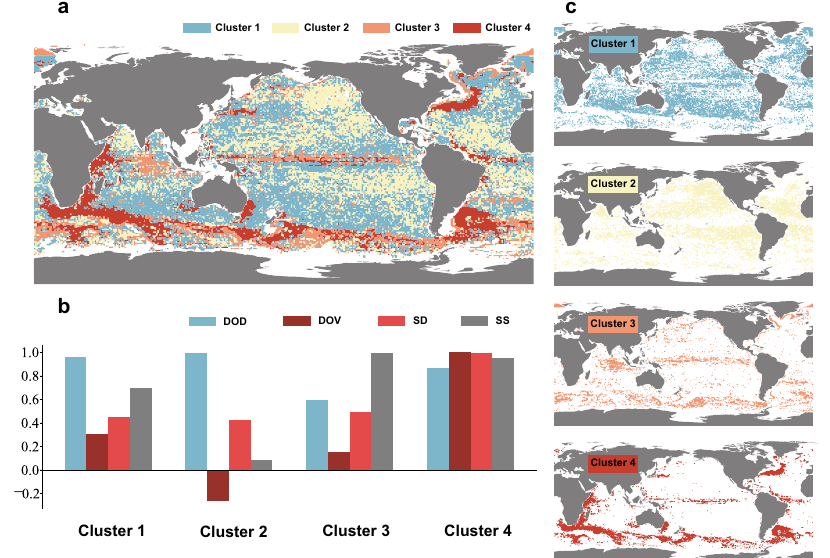
Fig. 3 | Multivariate K-means clustering analysis results for 4 clusters. a The clustering map shows spatial distribution, and ( b ) the column chart summarizes normalized indicators of displacement disparity for each cluster. c The separate